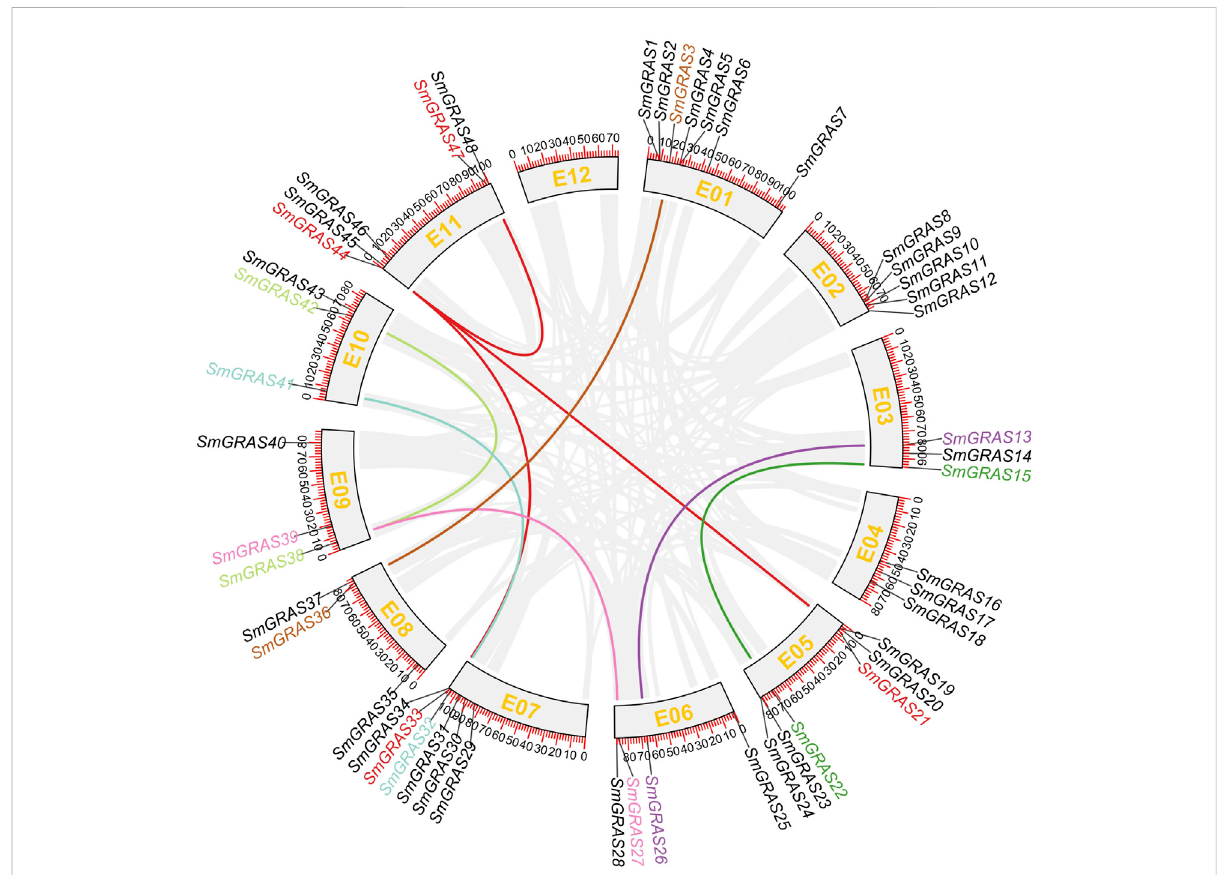
FIGURE 4 Collinearity analysis of SmGRASs. Scale bar on thechromosome shows the length of the chromosome (Mb). Genes with segmental duplication are shown in the same